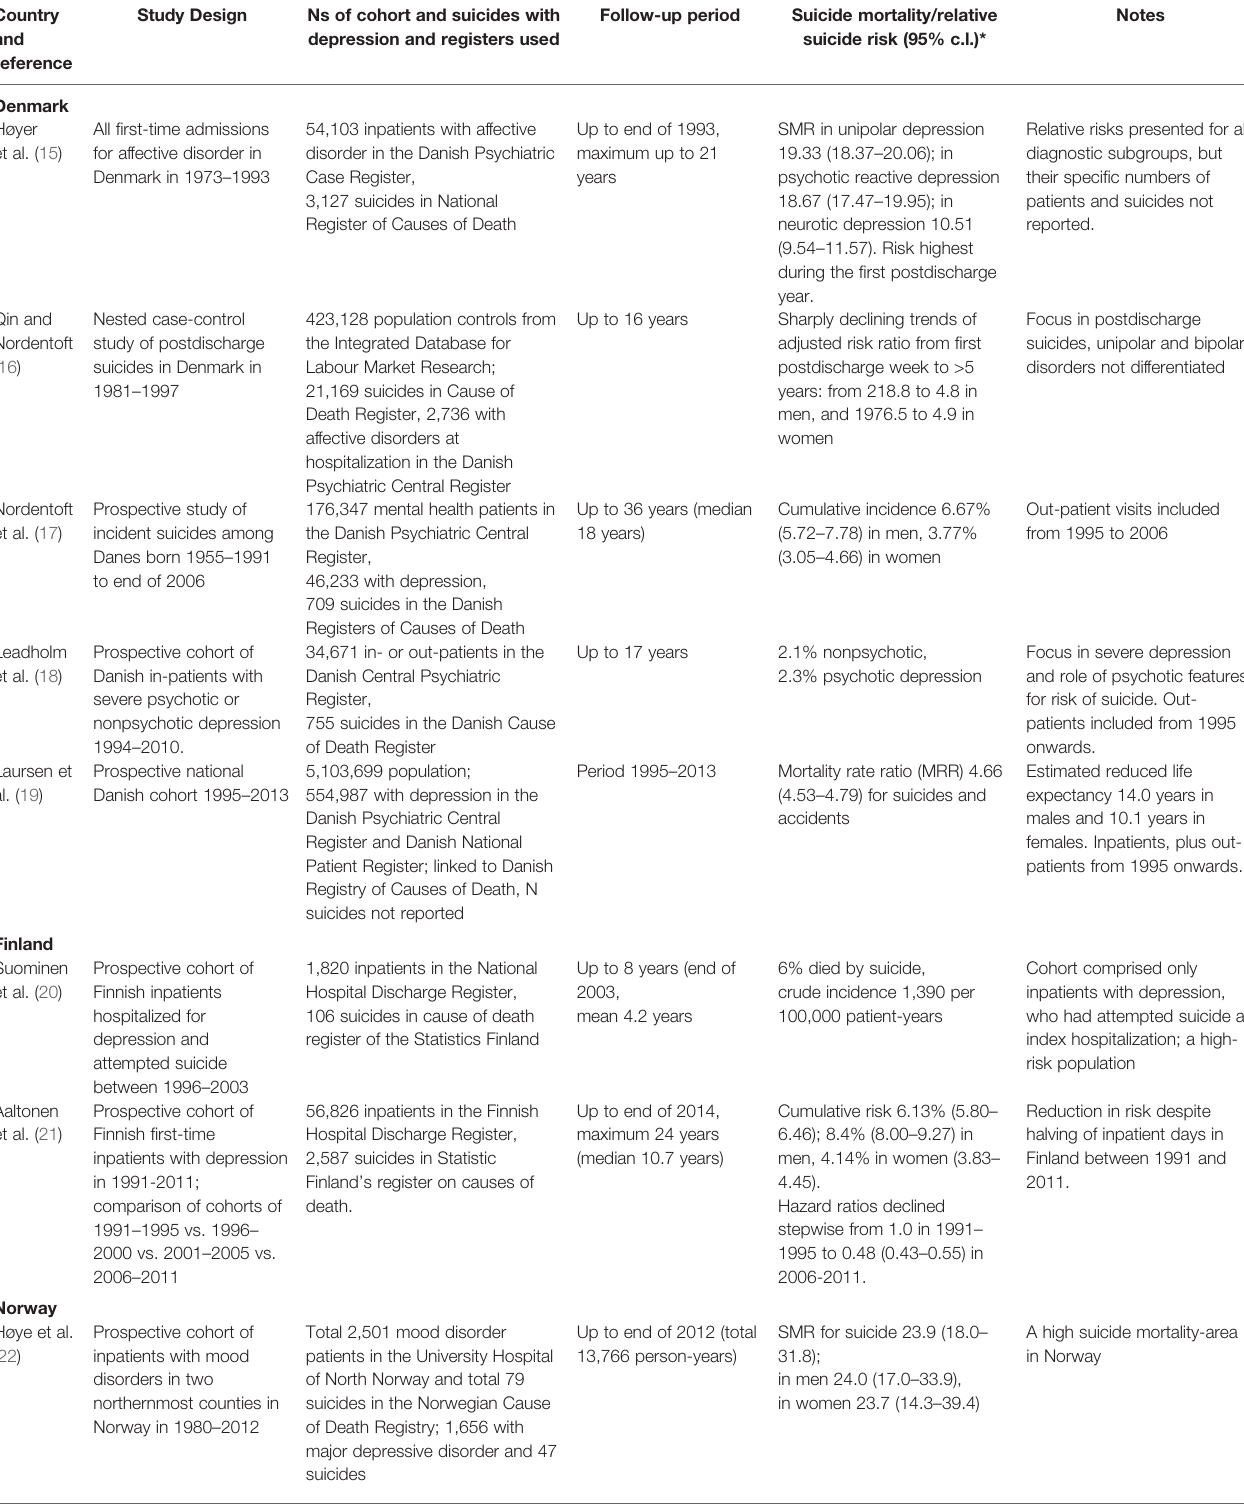
TABLE 1 | Suicide mortality in nationally representative register studies of unipolar depression in the Nordic